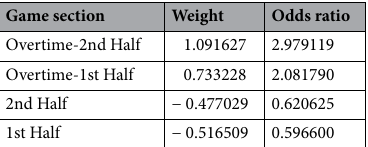
Table 6. Logistic regression model estimated weights and odds ratio for each possible value for Game section.